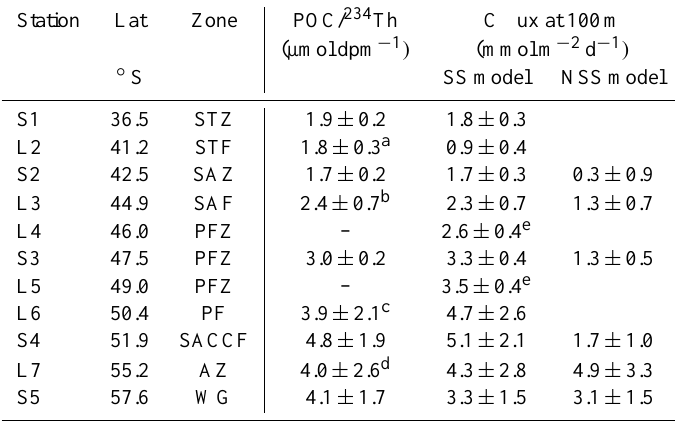
Table 3. POC export production at 100m (EP 100 ) in mmolm 2 d − 1 along the BGH section, as based on steady state (SS) and non steady state (NSS) models.